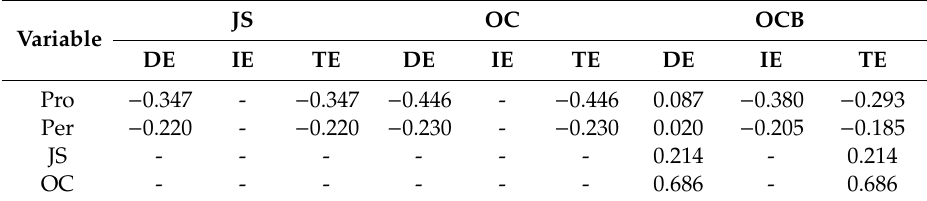
Table 4. Factors with direct, indirect, and overall